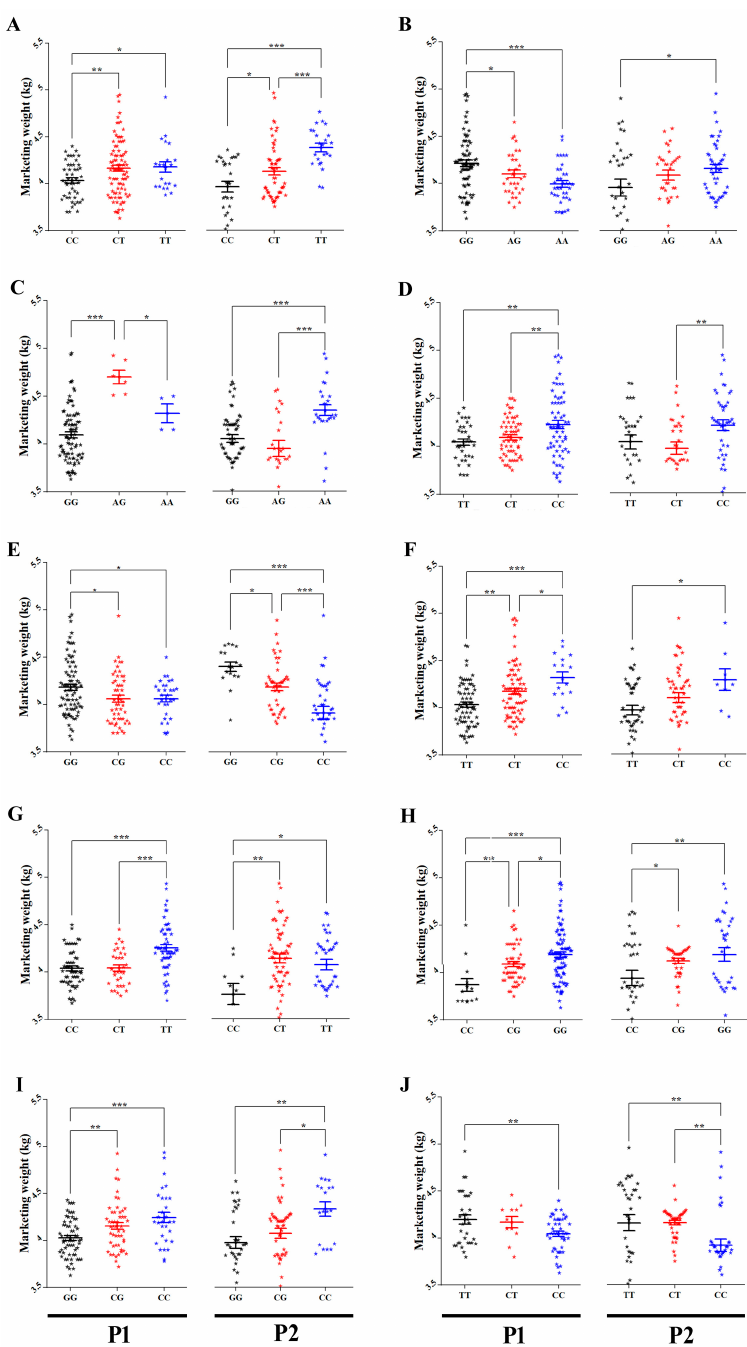
Figure 2. ( A ) Average marketing weights (kg) of each genotype of Record_1102, ( B ) Record_1111, ( C ) Record_2315, ( D ) Record_1009, ( E ) Record_1056, ( F ) Record_1115, ( G ) Record_7099, ( H ) Record_7097, ( I ) Record_8964, and ( J ) Record_396 SNPs in males of the P1 and P2, respectively. The X axis represents different genotypes groups of each SNP in males of the P1 and P2. The Y axis represents MW (kg). The error bars represent the standard error of mean. * p < 0.05, ** p < 0.01 and *** p <